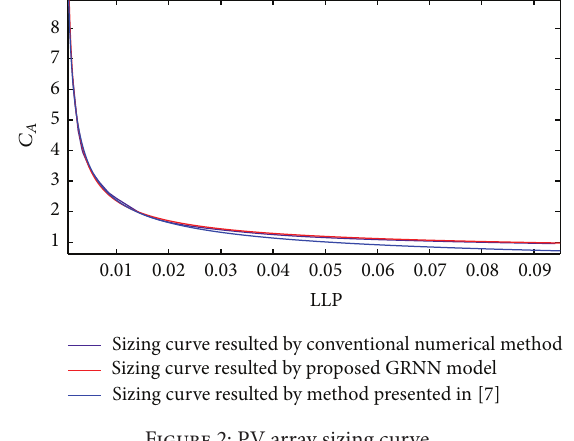
Figure 2: PV array sizing curve.